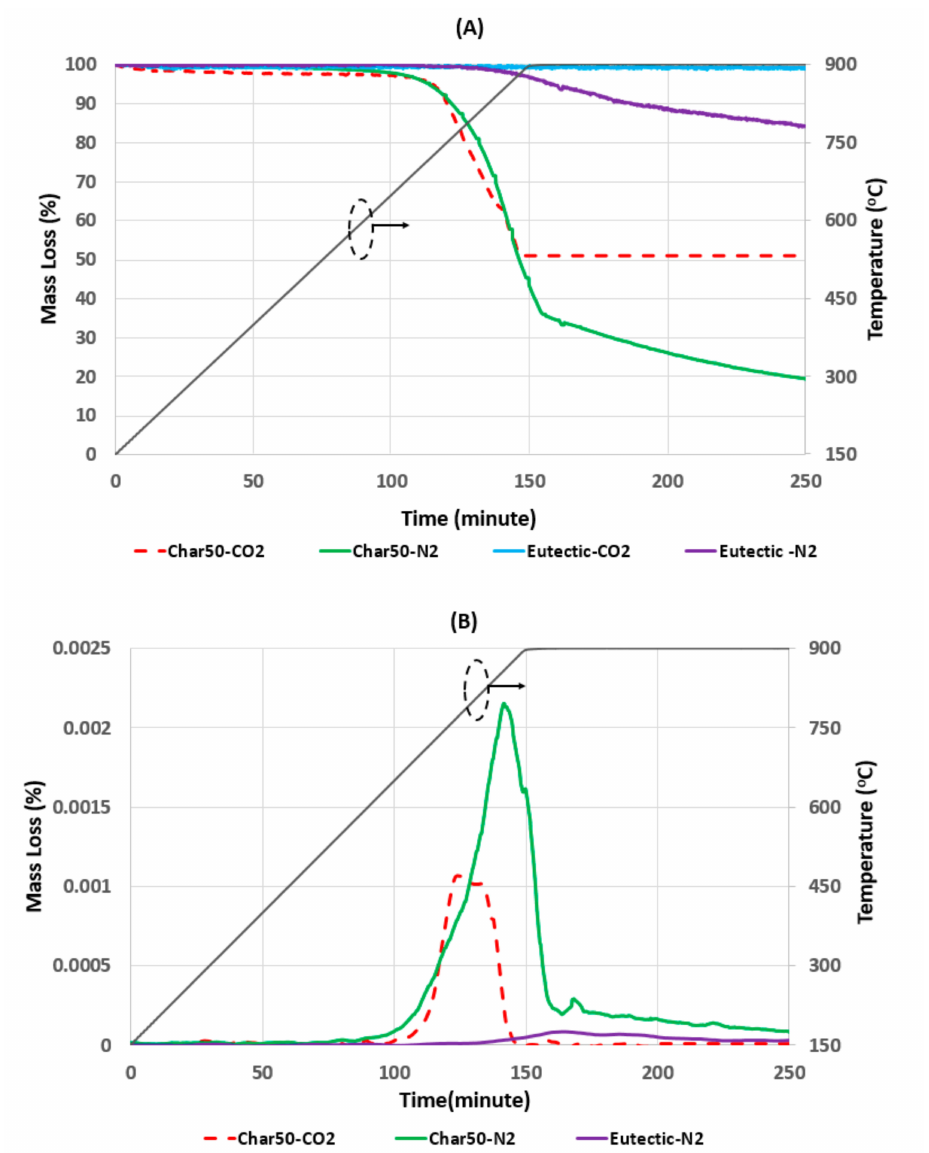
Figure 6. TGA mass changes ( A ) and DTG curve ( B ) of Char50 and eutectic. Stability under N 2 and CO 2 at 900 ◦